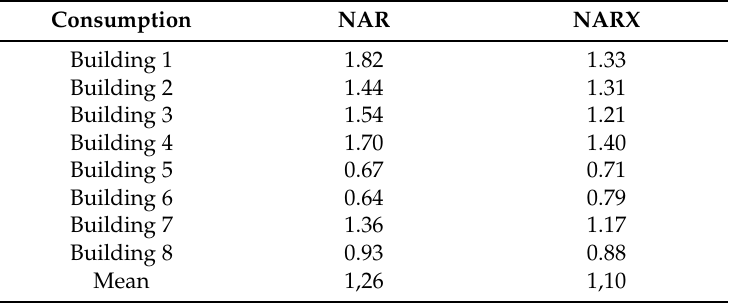
Table 5. Summary of NAR and NARX network performance (MSE) in all